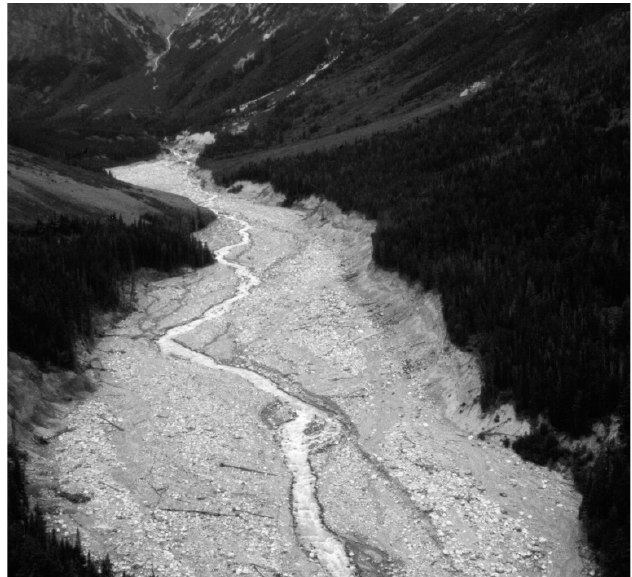
Figure 8. Floor of the west fork of Nostetuko River in the central Coast Mountains of British Columbia following the outburst flood from moraine-dammed Queen Bess Lake in August 1997. The floodwaters entrained and transported sediment on the valley floor and eroded the valley walls. This event has been documented by [97].